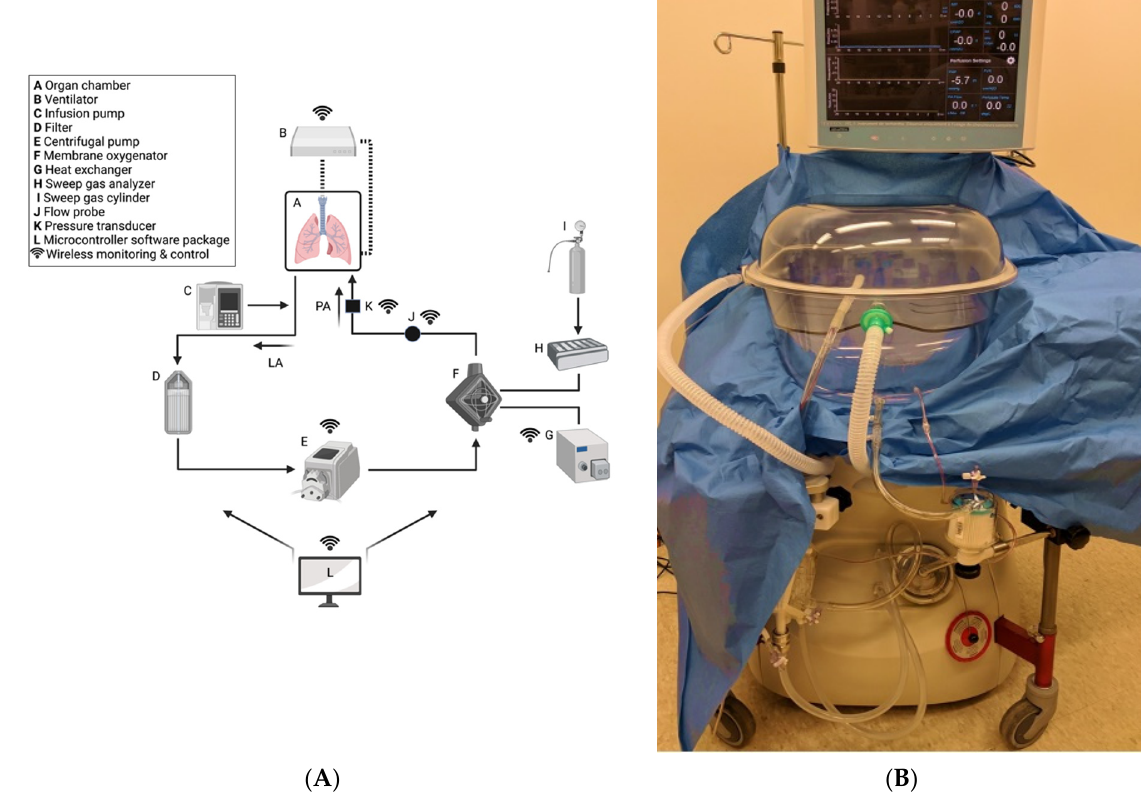
Figure 2. Custom-built NPV-ESLP platform: ( A ) Schematic of NPV-ESLP components; ( B ) Tevosol Inc. clinical trial prototype. ( A ) Oxygenated perfusate drains from the open left atrial system into a hard-shell reservoir (A), then through an arterial/particulate filter (D), pumped via the centrifugal pump (E) to the oxygenator/heat exchanger (F,G); which in turn warms the perfusate to normothermia (computer-controlled/adjusted (L)) and deoxygenates it with a sweep gas mixture (H,I). Prior to re-entering the lungs via the pulmonary arterial cannula (PA) for re-oxygenation, the perfusate passes by a flow probe sensor (J) and a pressure transducer (K). Negative Pressure Ventilation (NPV) circuit is depicted (B). An infusion pump (C) infuses insulin, dextrose, volume, and medications as needed.